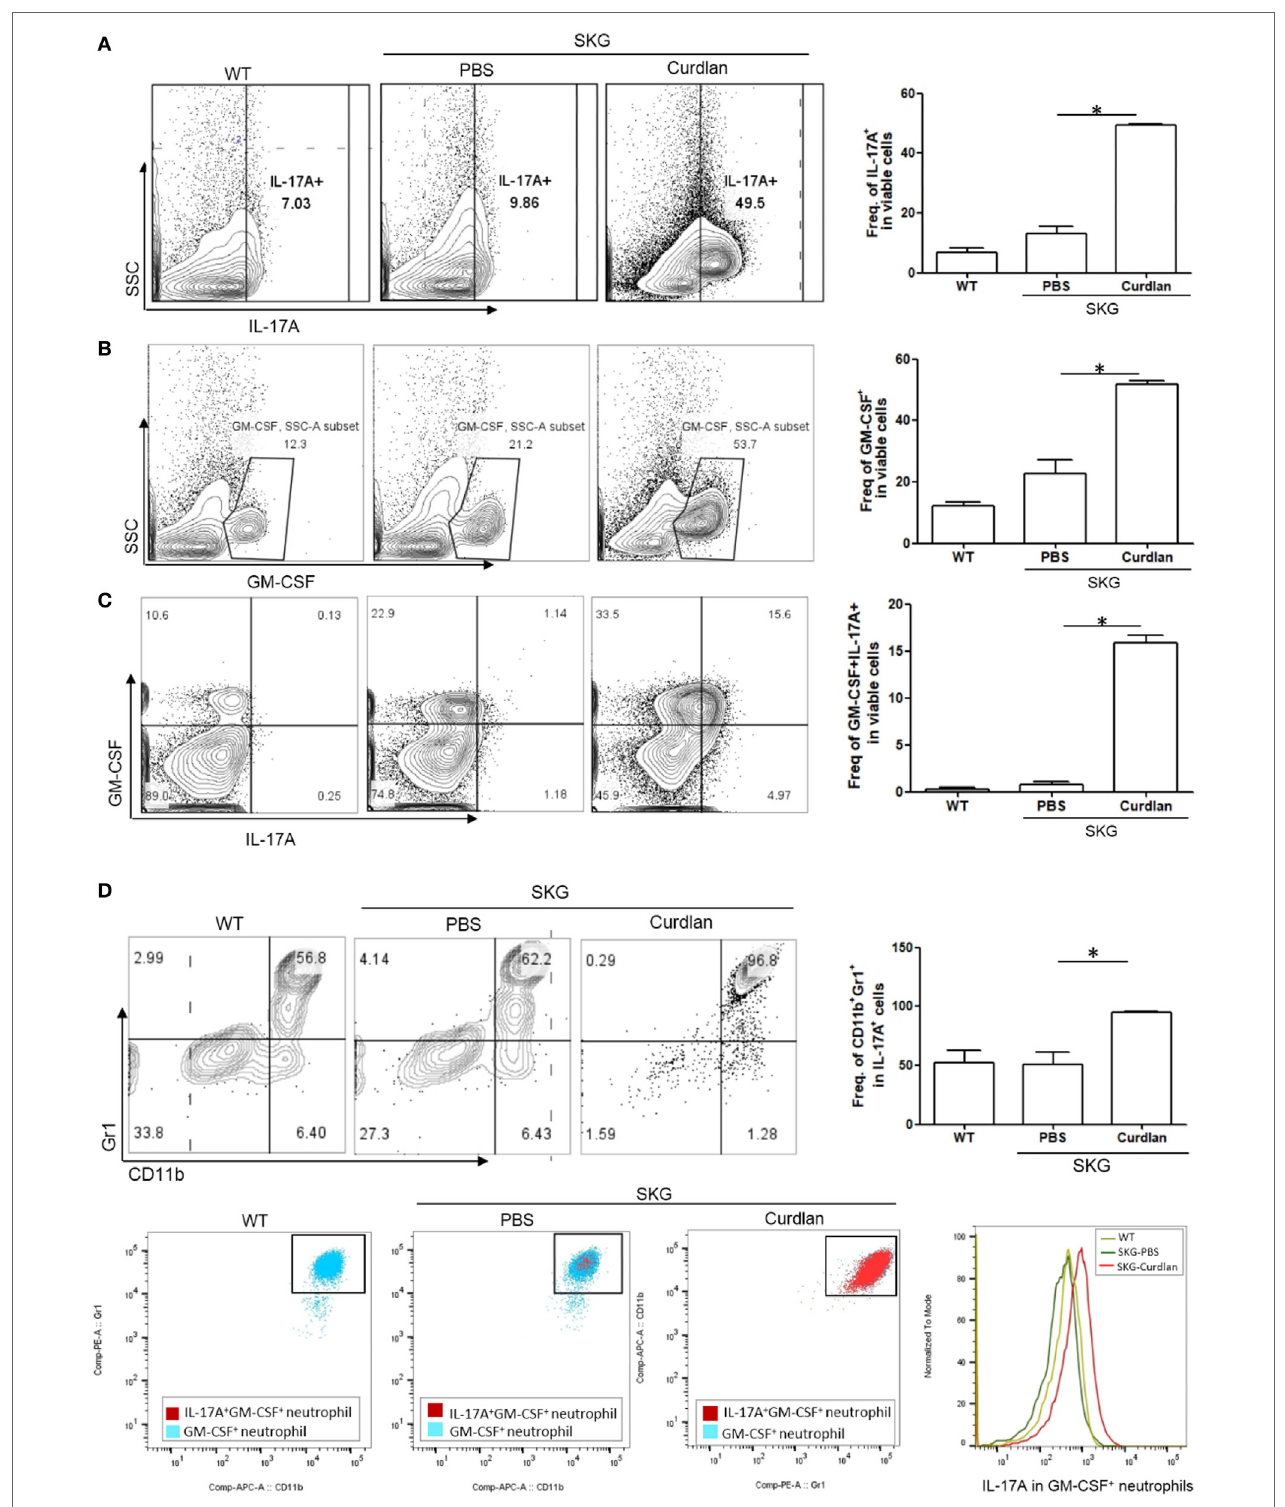
FigUre 3 | IL-17A + GM-CSF + neutrophils in the lungs of curdlan-treated SKG mice. Flow cytometry plots showing (a) proportion of IL-17A + cells among lung- infiltrating cells, (B) proportion of GM-CSF + cells among lung-infiltrating cells, and (c) proportion of IL-17A + and GM-CSF + cells among lung-infiltrating cells. (D) Lung-infiltrating cells were gated on IL-17A expression and stained for Gr1 and CD11b. In the lungs of curdlan-treated SKG mice, nearly almost all IL-17A + viable cells were CD11b + Gr1 + neutrophils, and GM-CSF + neutrophils also expressed IL-17A mostly. Values in (a–D) are mean ± SEM. * p < 0.05 by Mann–Whitney U test.